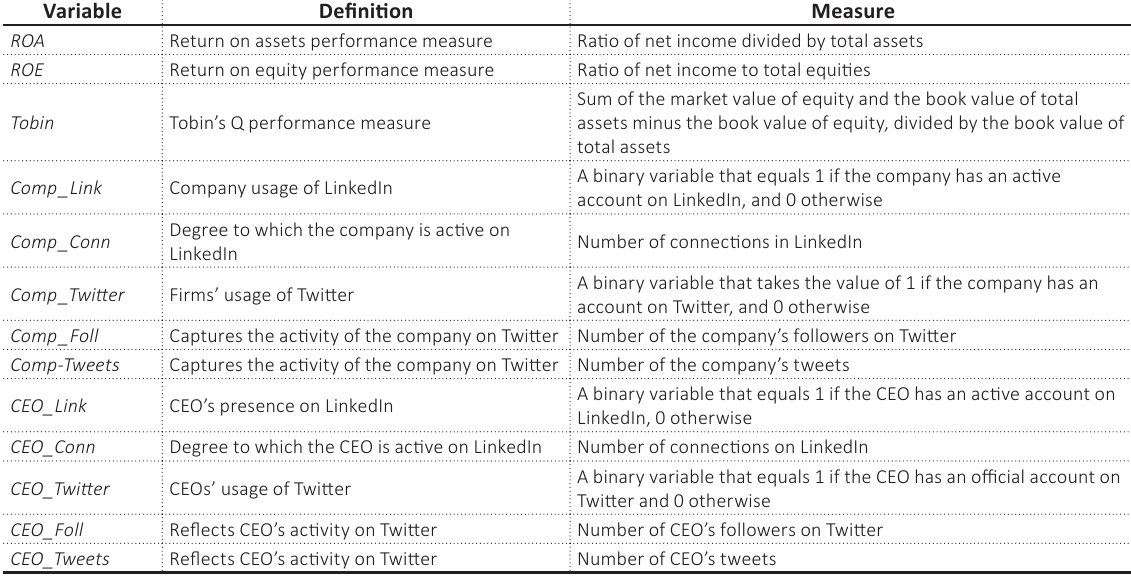
Table 1. Variables’